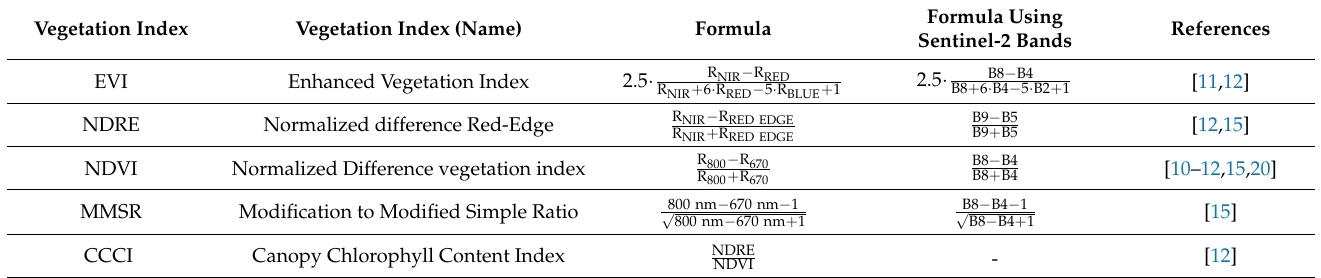
Table 2. Vegetation indices used in this work and their references. The original formulas are reported indicating the reflectance bands (R band ) or the wavelengths (expressed in nm). The formulas using Sentinel-2 bands identify the corresponding satellite band (B)